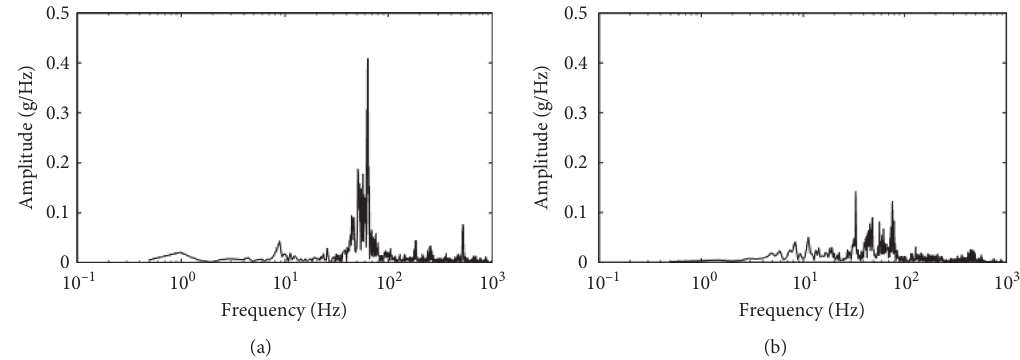
Figure 6: FFT results of the test signals. (a) The motor bogie frame and (b) The trailer bogie